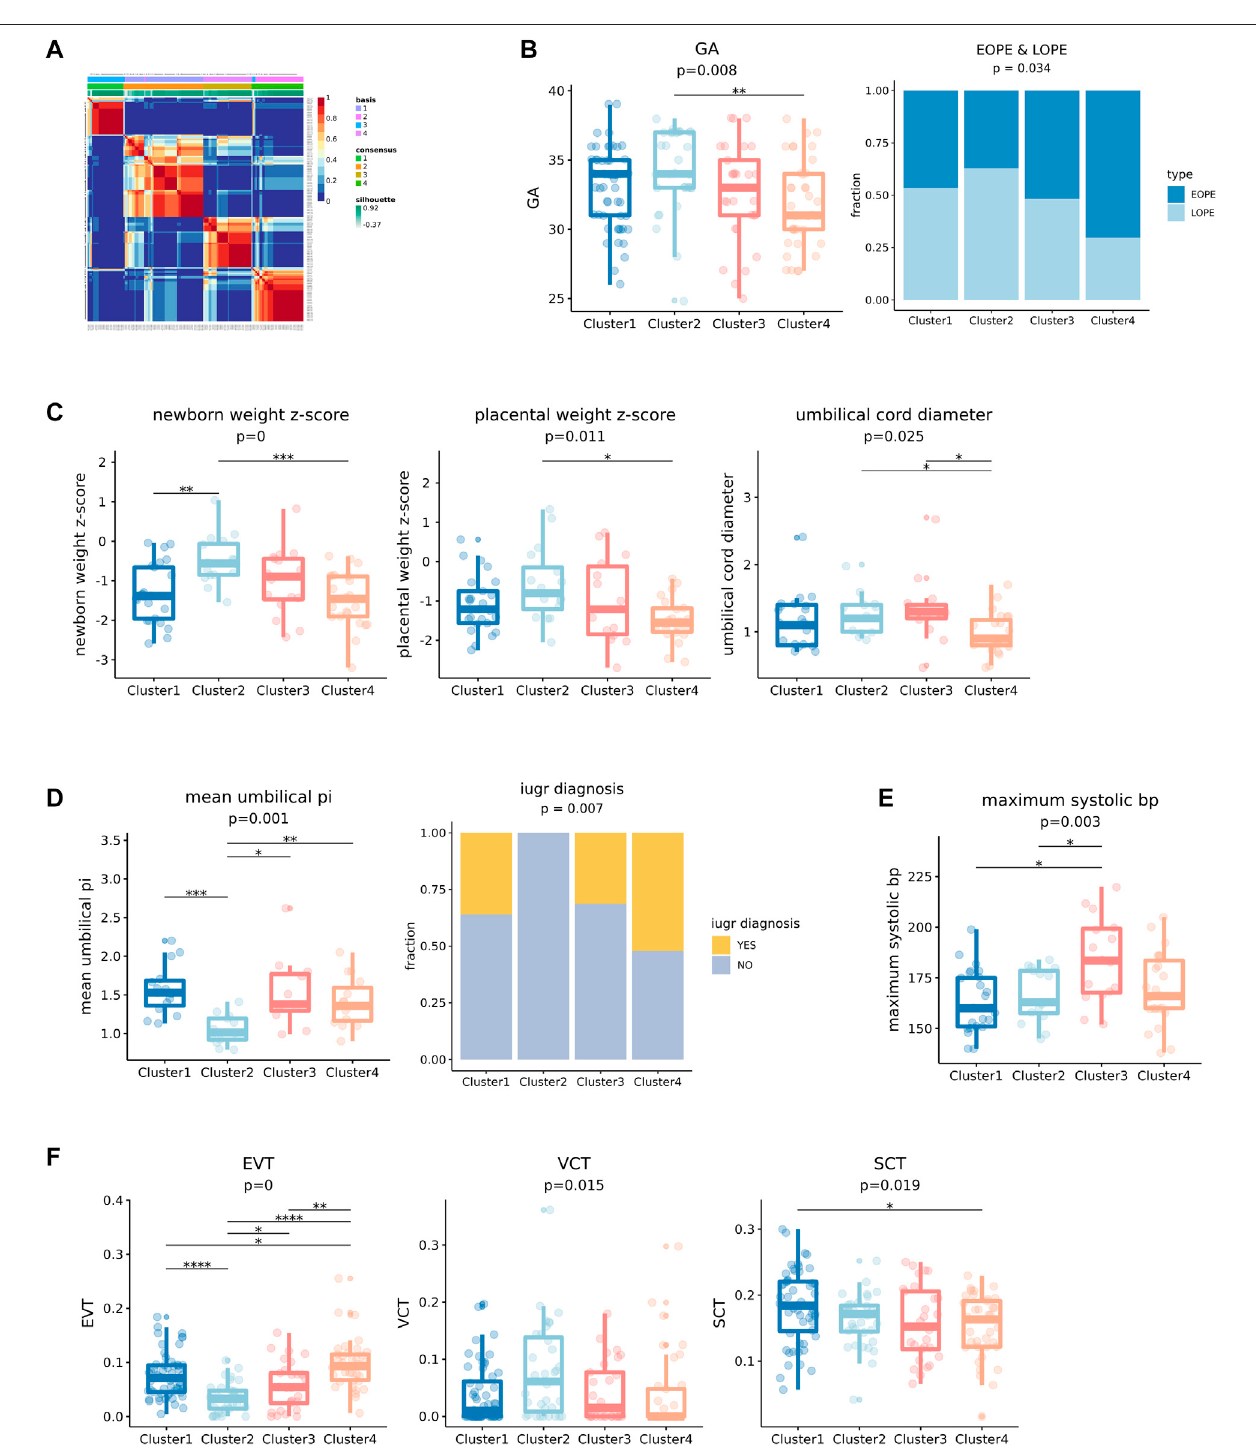
FIGURE 6 | Unsupervised clustering results of integrated fi ve cell types of transcriptional pro fi les of PE by NMF and signi fi cance testing of clinical features. (A) Unsupervised clustering result of integrated cell types transcription pro fi les using NMF, the consensus matrix of NMF output display that four stable clusters can be obtained. (B) The four clusters showed signi fi cant differences in gestational age (GA), and the fraction of EOPE and LOPE. (C) The four clusters showed signi fi cant differences in newborn weight z-score, placental weight z-score, and umbilical cord diameter which re fl ect the state of fetal development. (D) The four clusters showed signi fi cant differences in mean umbilical PI and the fraction of IUGR in the cluster. A higher mean umbilical PI indicates a greater likelihood of IUGR. (E) Four clusters showed signi fi cant differences in maximum systolic bp. (F) Differences in the proportion of three kinds of trophoblast cells (EVT, VCT, and SCT) in four clusters of